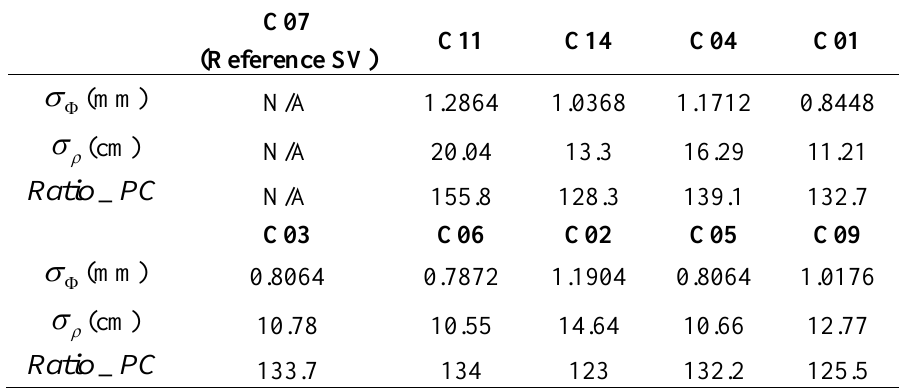
Table 2. Standard deviation of BD2 code and phase observations in static experiments.